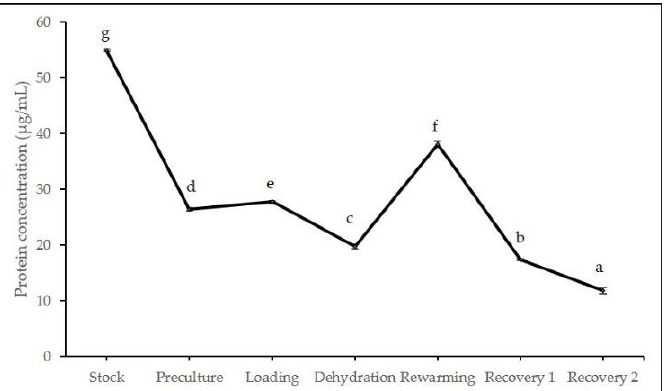
Figure 7. Total soluble protein content of cryopreserved axillary buds at different stages in cryopreservation. Error bars represent standard errors. Means with different letters are significantly different based on Duncan Multiple Range Test (DMRT) at p ≤ 0.05.